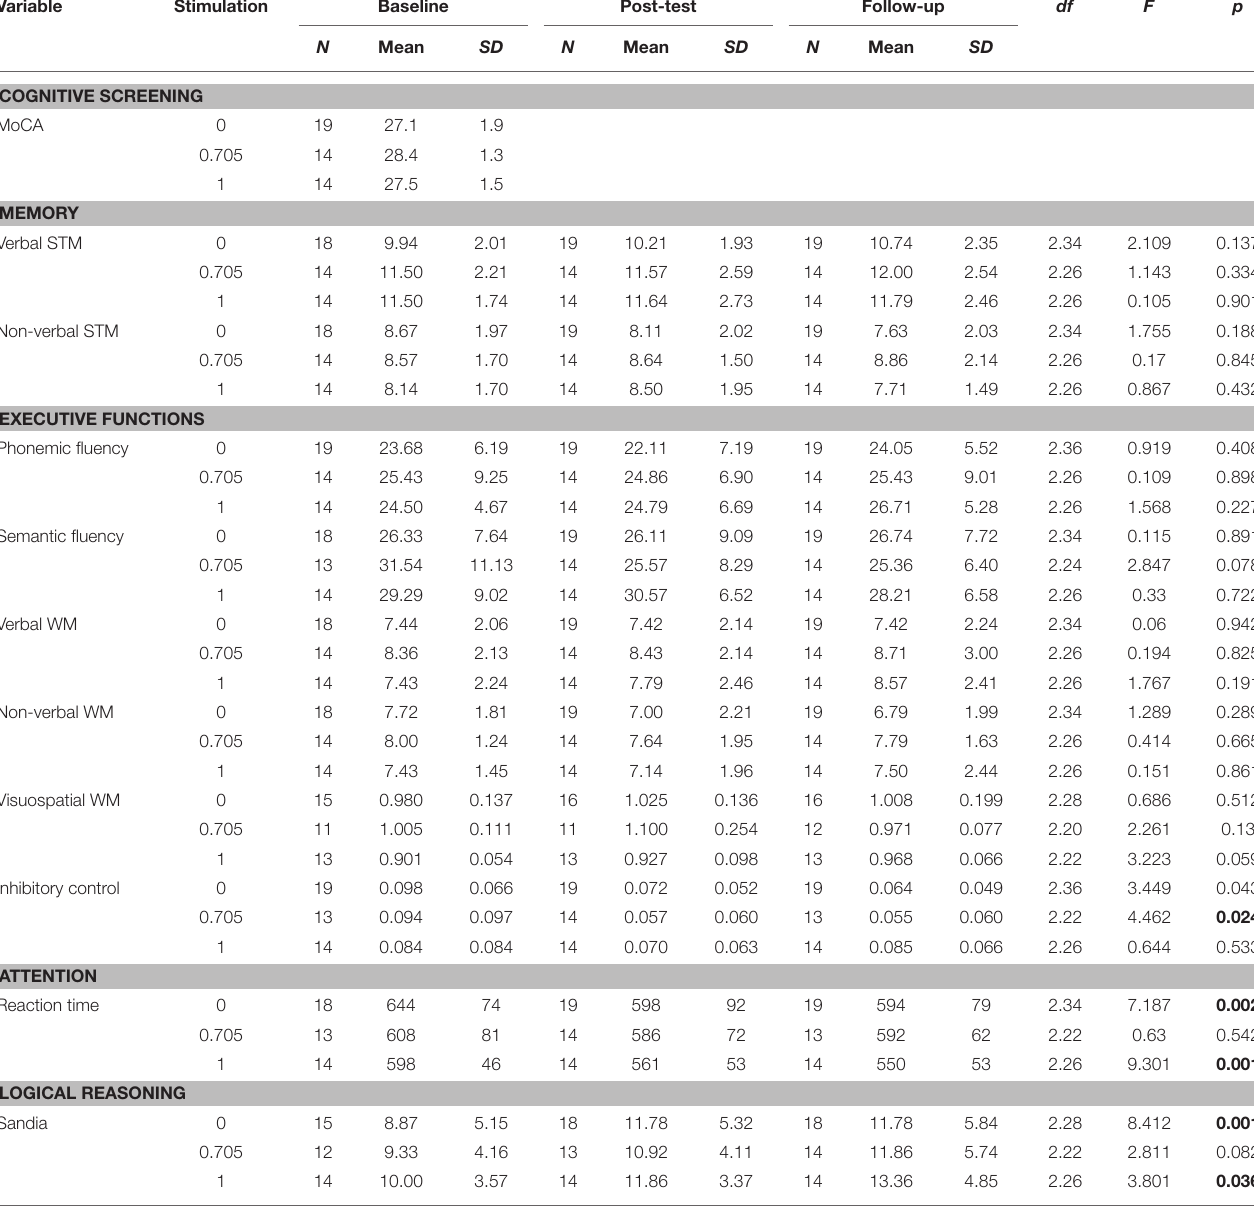
TABLE 2 | Neuropsychological outcomes at baseline, post-testing, and follow-up. Variable Stimulation Baseline Post-test Follow-up df F p N Mean SD N Mean SD N Mean SD